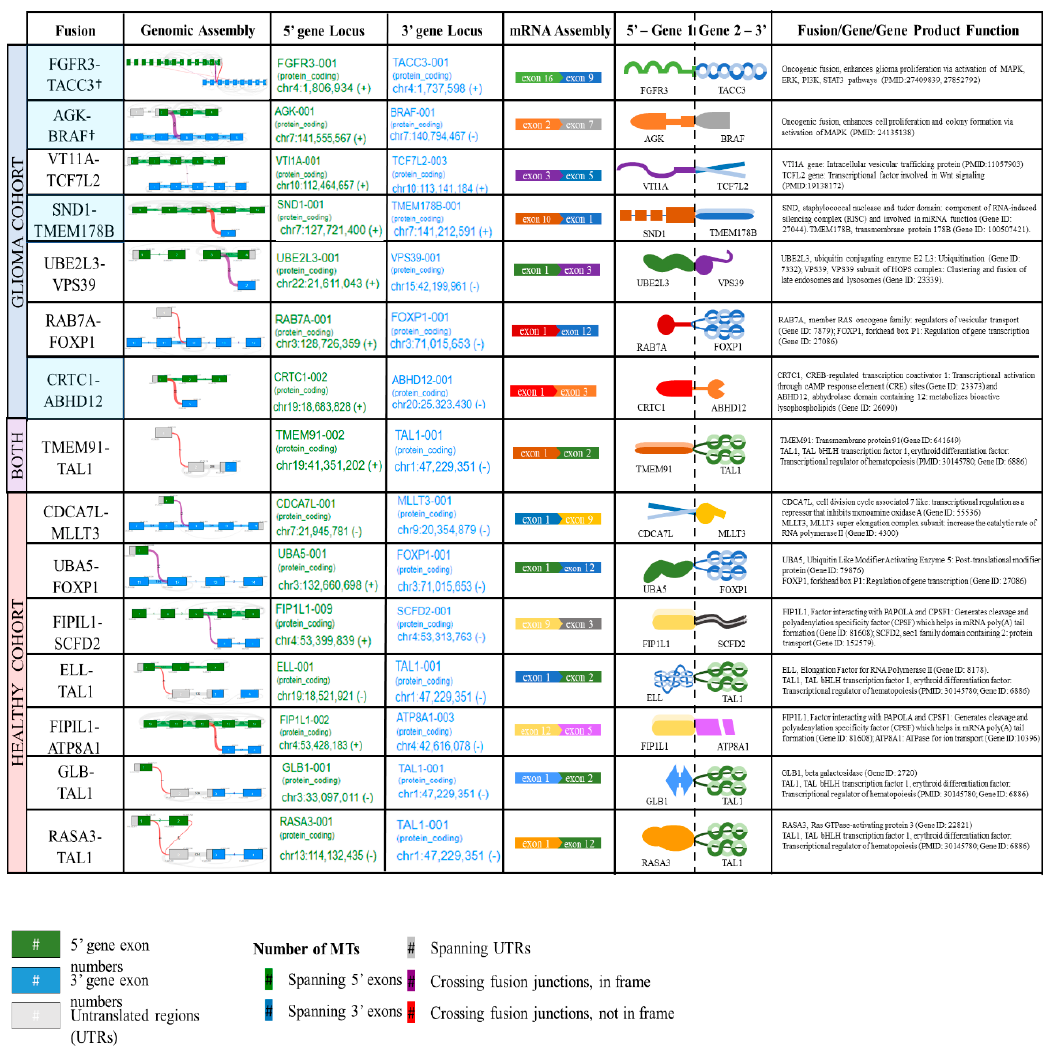
Figure 3. Annotation of gene fusions at genomic, transcriptomic and fusion protein level. Summary of genomic assembly, gene locus (QIAseq RNAscan Analysis Report generated on GeneGlobe), mRNA assembly, hypothetical fusion protein diagram and gene fusion / gene function. † , fusions with documented oncogenic function. Light blue shade indicates the GBM fusions in hotspot regions.